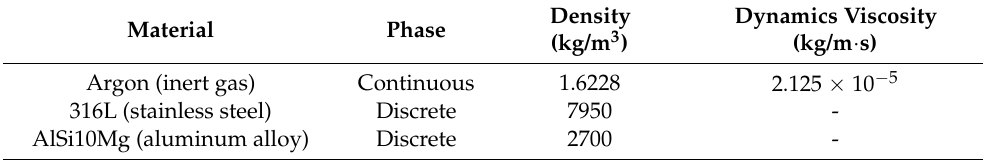
Table 1. Thermophysical properties of inert gas and spatter. Virgin powder diameter: 60 µ m.